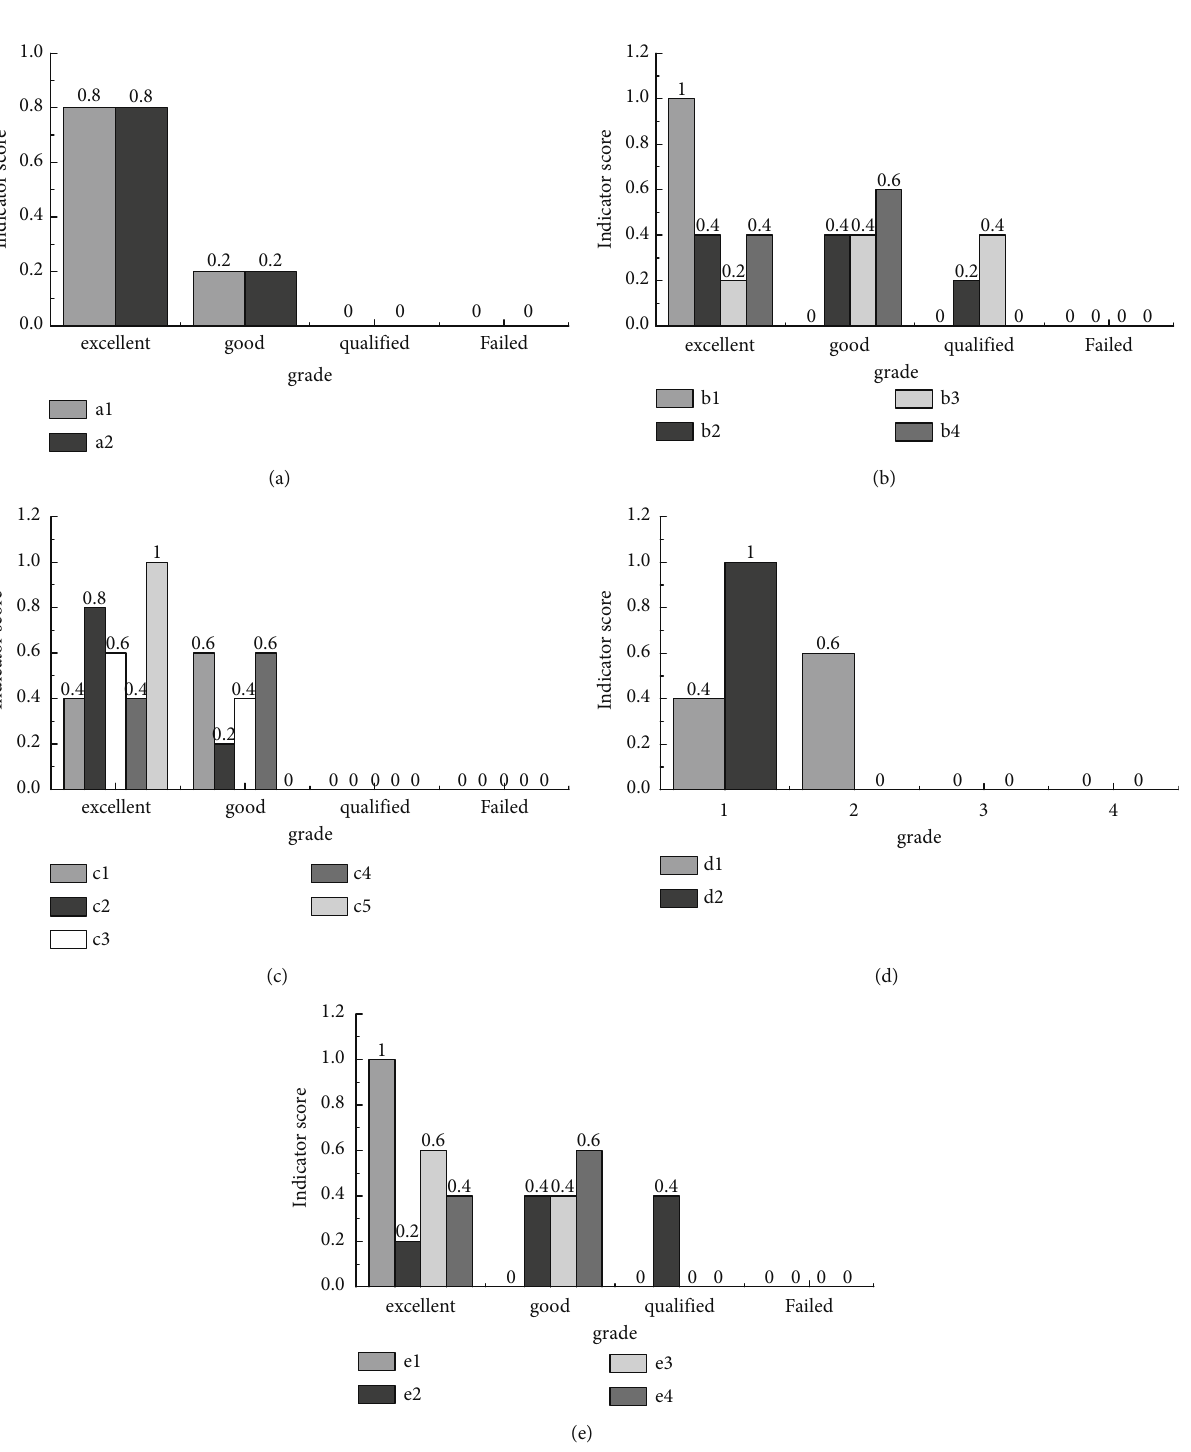
Figure 10: The speci fi c index scoring results. (a) index score. (b) Index score. (c) Index score. (d) Index